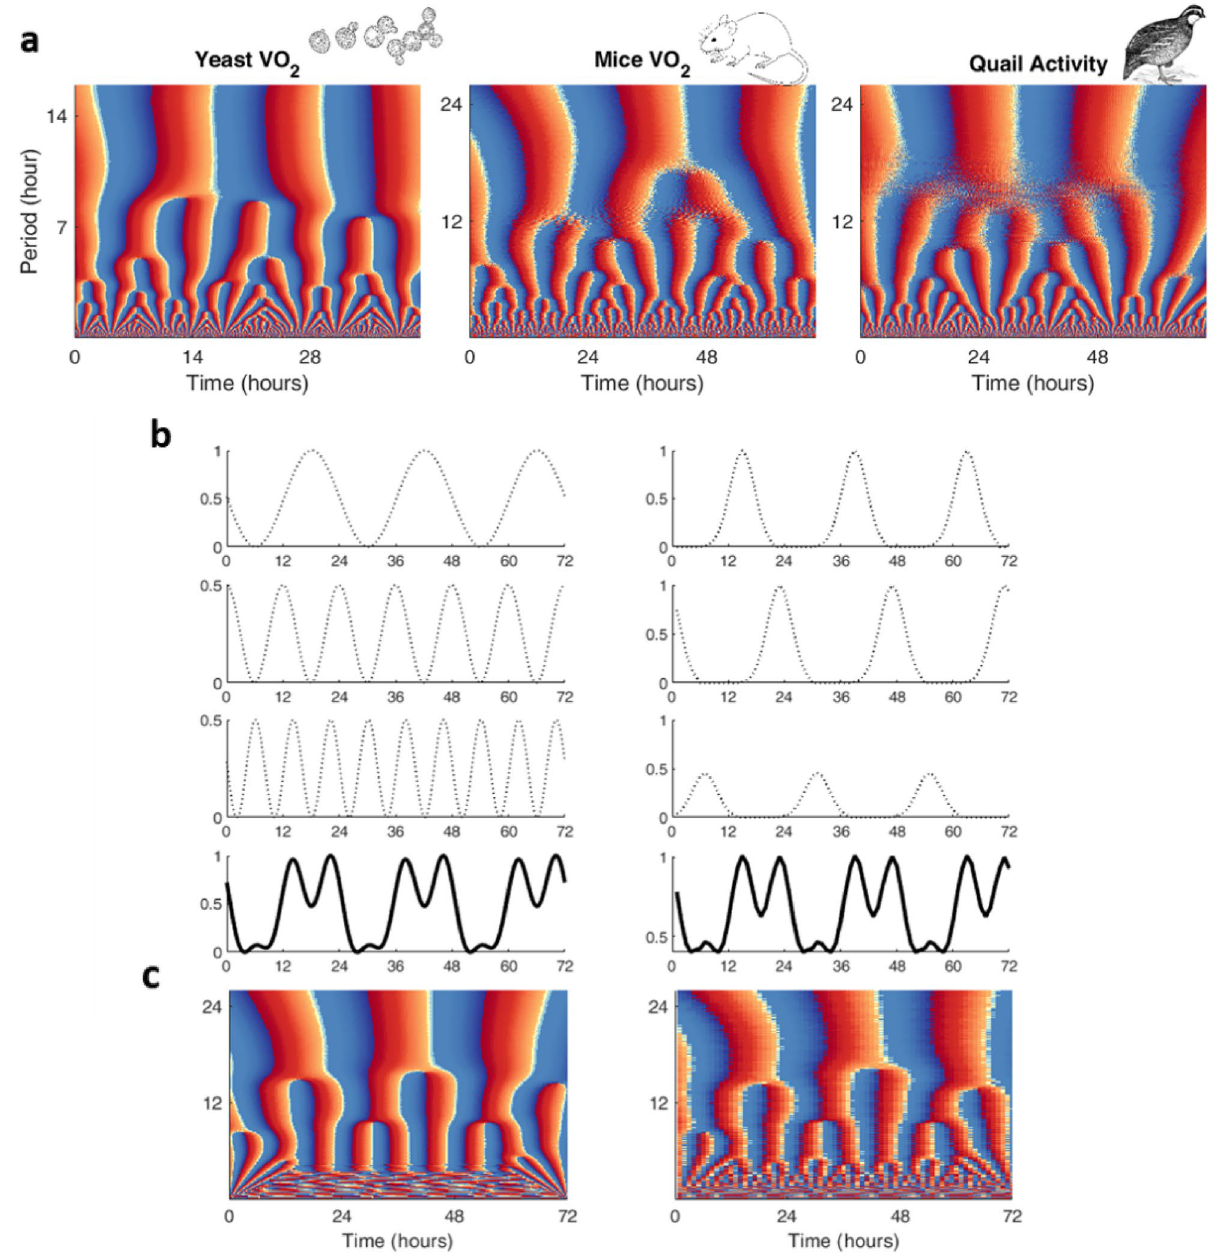
Figure 5. Resemblant dynamic pattern of circadian and ultradian rhythms in mice, quails and yeast can be understood by two distinct mechanisms. Visual comparison between time series analysis with the complex Morlet cwt (only phase angle is shown): ( a ) left panel, dissolved O 2 obtained by MIMS from oscillating continuous cultures of S. cerevisiae (same as in Fig. 1a); middle panel, O 2 consumption rate of wild-type female mice in metabolic cages (same as in Fig. 3a); and right panel, spontaneous locomotor activity of an adult female japanese quail in a home box environment (same as in Fig. 4a). ( b ) Two theoretical models that can give rise to the observed bifurcation patterns. On the left, three sinusoidal oscillations with different amplitudes and periods of 24 h, 12 h and 8 h were summed to create the synthetic time series shown in solid black lines on the bottom panel. On the right, three different trains of gaussian curves with peaks separated by 24 h periods are summed to create the synthetic time series (bottom panel). ( c ) Wavelet analysis of both synthetic time series. The same general bifurcation pattern is observed and of similar appearance as the time series from living organisms shown in panel